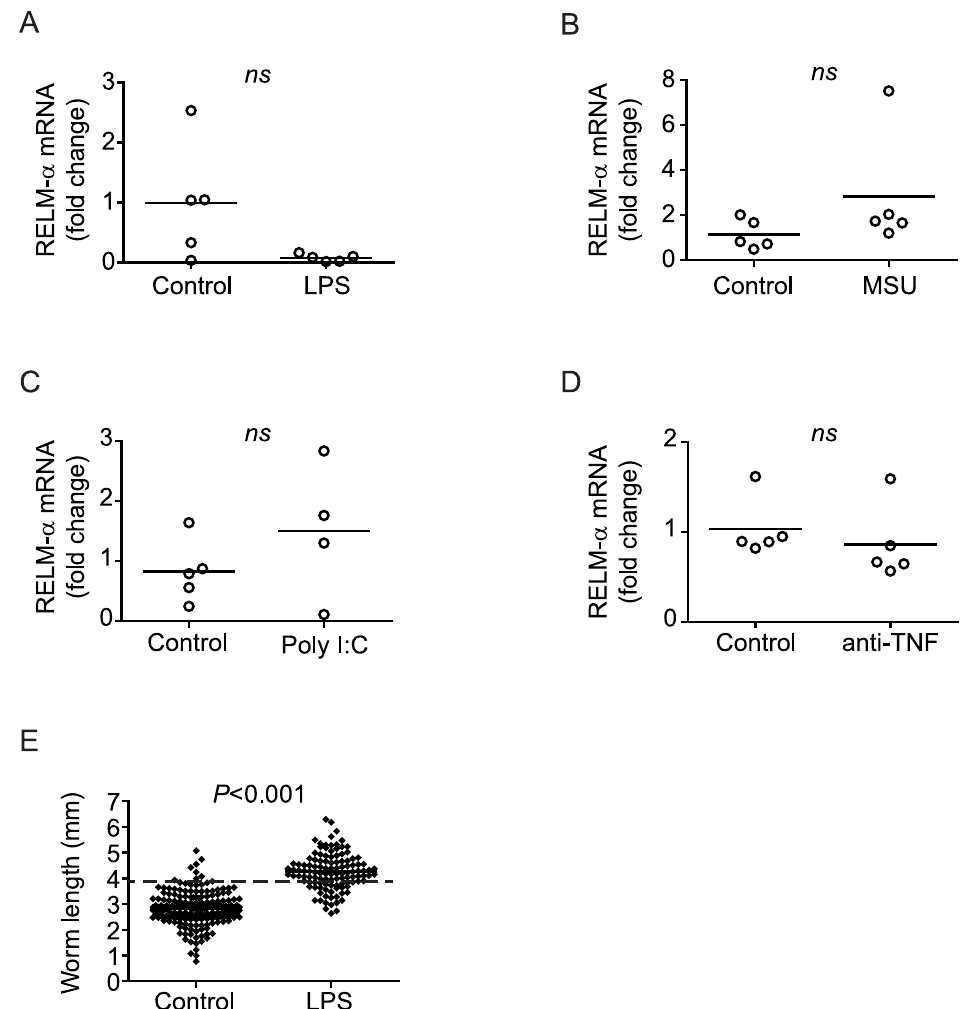
Figure 8. Restoration of parasite development is not dependent on M2 responses. Groups of S. mansoni -infected RAG 2 / 2 mice were repeatedly treated throughout pre-patent infection with either LPS (A) or MSU (B), poly I:C (C) or anti-TNF antibody (D) as described in Materials and Methods. At 6 weeks p.i., mice were euthanized and livers removed for analysis of RELM- a mRNA content by real-time PCR. E, groups of RAG 2 / 2 / c c 2 / 2 were infected with S. mansoni and repeatedly treated throughout per-patent infection with LPS or PBS (control), as described in Materials and Methods. Parasites were perfused from the portal system at 6 weeks p.i. and the length of the male worms measured. Horizontal bars represent mean values for each experimental group. P values were calculated using the Mann Whitney test. Dashed line in E indicates the average length of male S. mansoni worms recovered from wild type mice at day 42 post infection (3.9 mm).